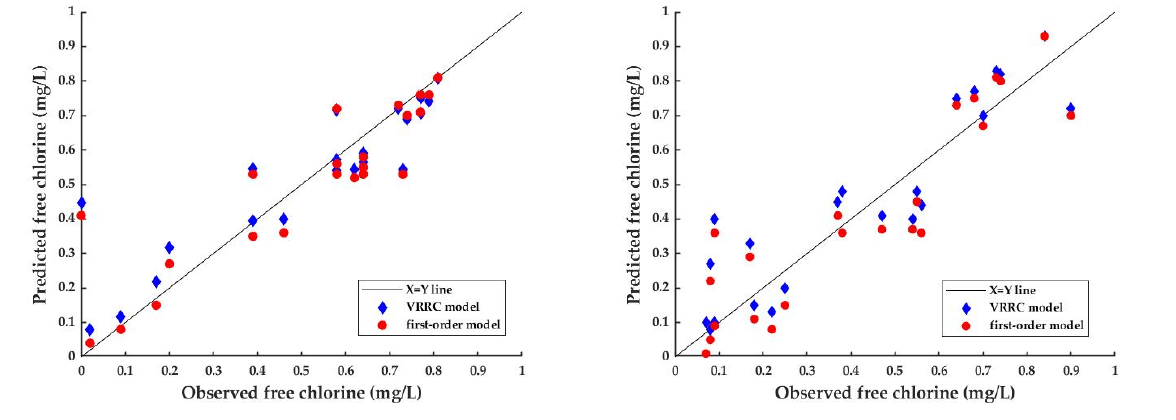
Figure 5. Free chlorine prediction results in the DS of city B using the VRRC model compared to the 1st-order model.